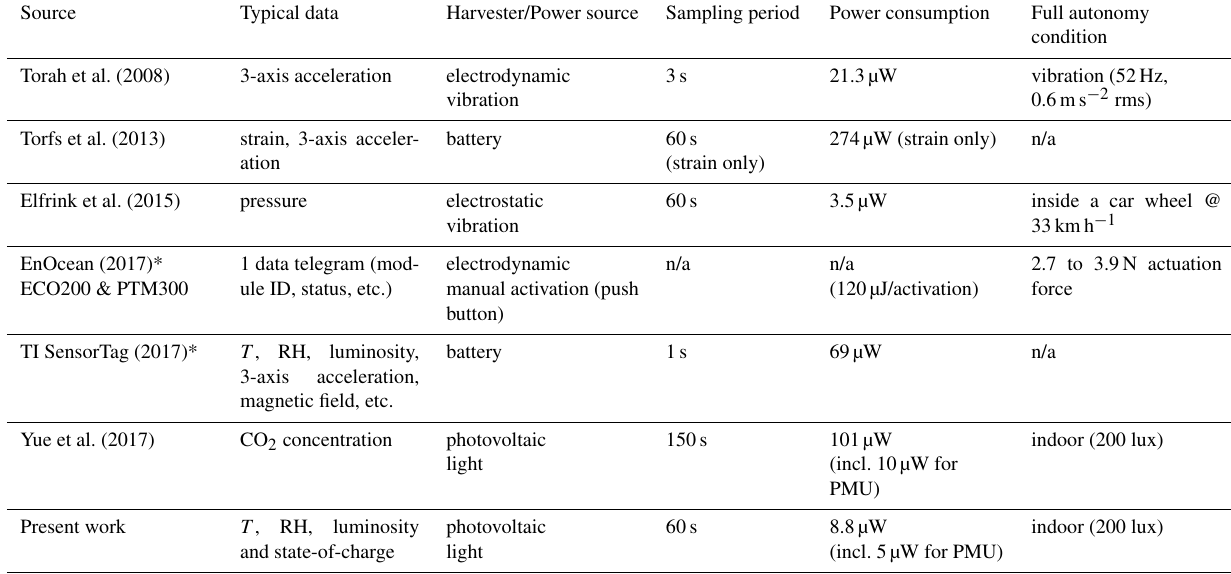
Table 1. Comparison of wireless microsystems discussed. n/a – not